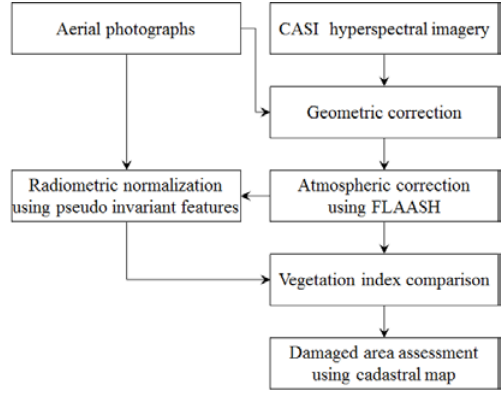
Figure 2. Workflow chart for the processing used in this